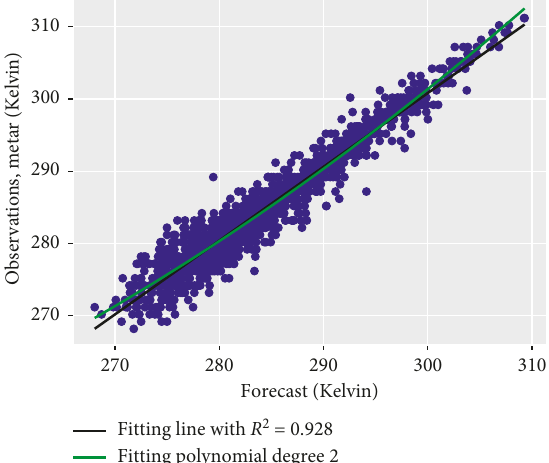
Figure 8: T2m scatter plot for Madrid airport, c SREPS member 019: LBCs JMA/GSM with the WRF-ARW NWP